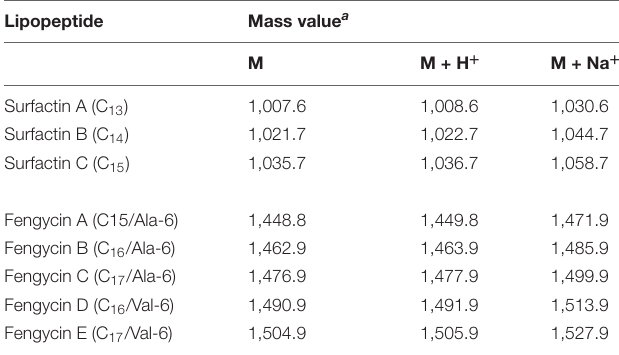
TABLE 1 | Calculated mass values of M, M + H + , and M + Na + ions corresponding to identified isoforms of surfactins and fengycins in culture extracts from B. subtilis